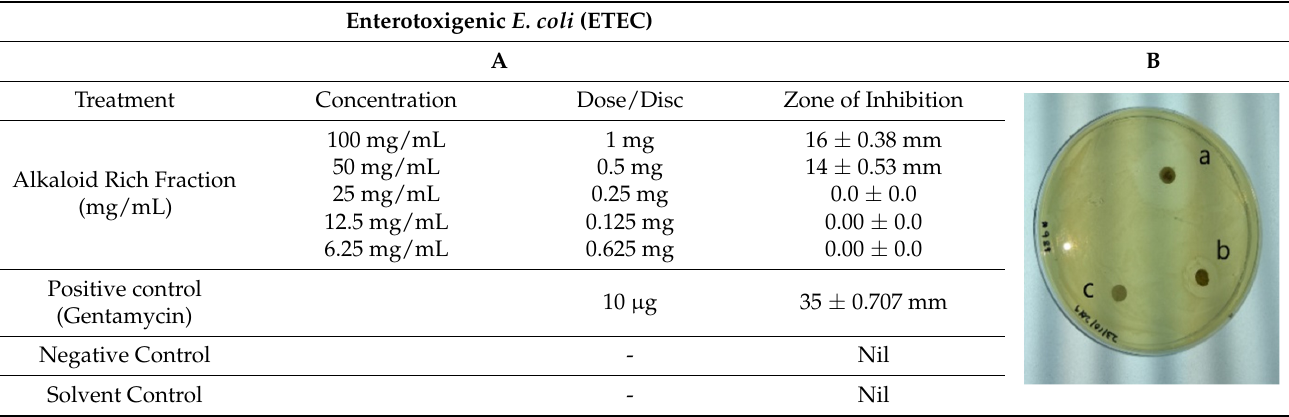
Table 1. ( A ): Mean diameter of inhibition zones (mm) for E. coli (ETEC) growth inhibited by alkaloid rich fraction of Holarrhena pubescens (kutaj). ( B ): Disc diffusion test for antimicrobial activity of Holarrhena pubescens (kutaj): ( a ) Zone of inhibition of positive control (gentamycin), ( b ) Zone of inhibition of alkaloid fraction, ( c ) Zone of inhibition of negative control.